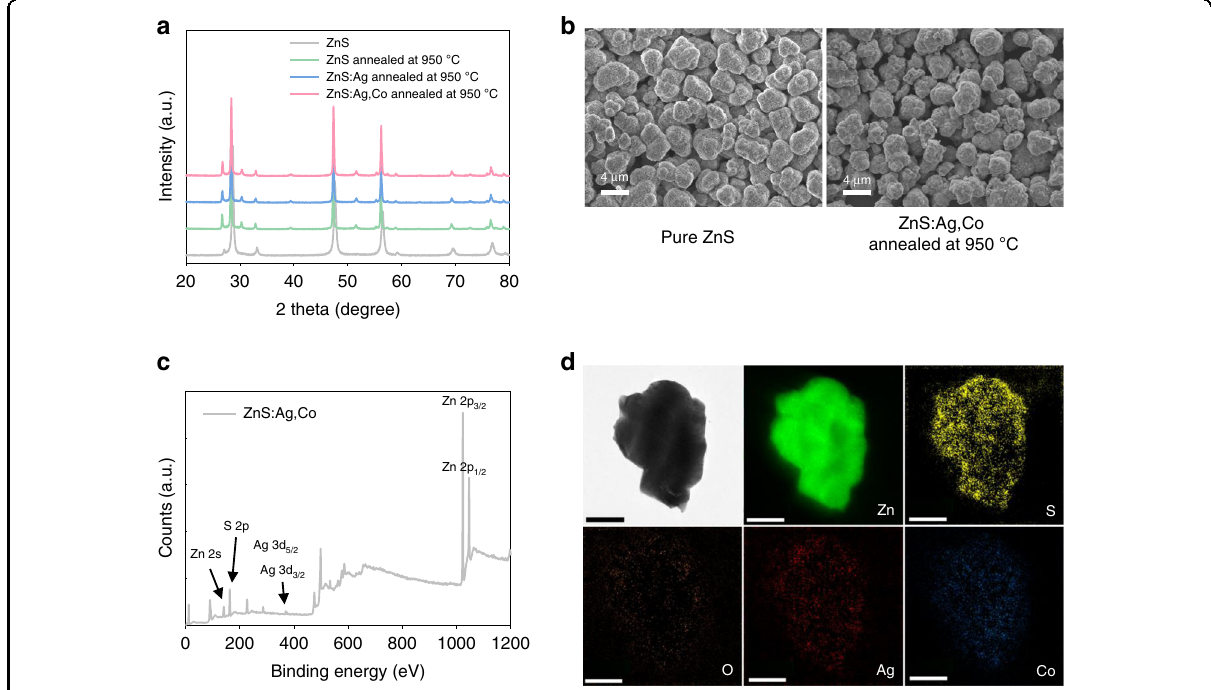
Fig. 2 Characterization of ZnS:Ag,Co particles. a XRD spectrum of ZnS, ZnS:Ag, and ZnS:Ag,Co particles with or without annealing at 950 °C under argon atmosphere. b SEM images of pure ZnS and ZnS:Ag,Co particles annealed at 950 °C. c XPS spectrum and d EELS elemental mapping images of ZnS:Ag,Co particles after calcination, respectively (scale bar = 500